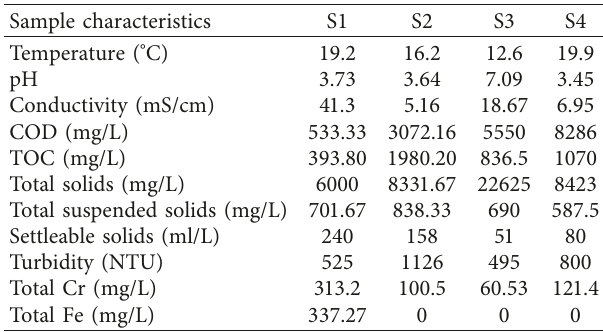
Table 1: Initial characteristics of wastewater at different stages. Sample